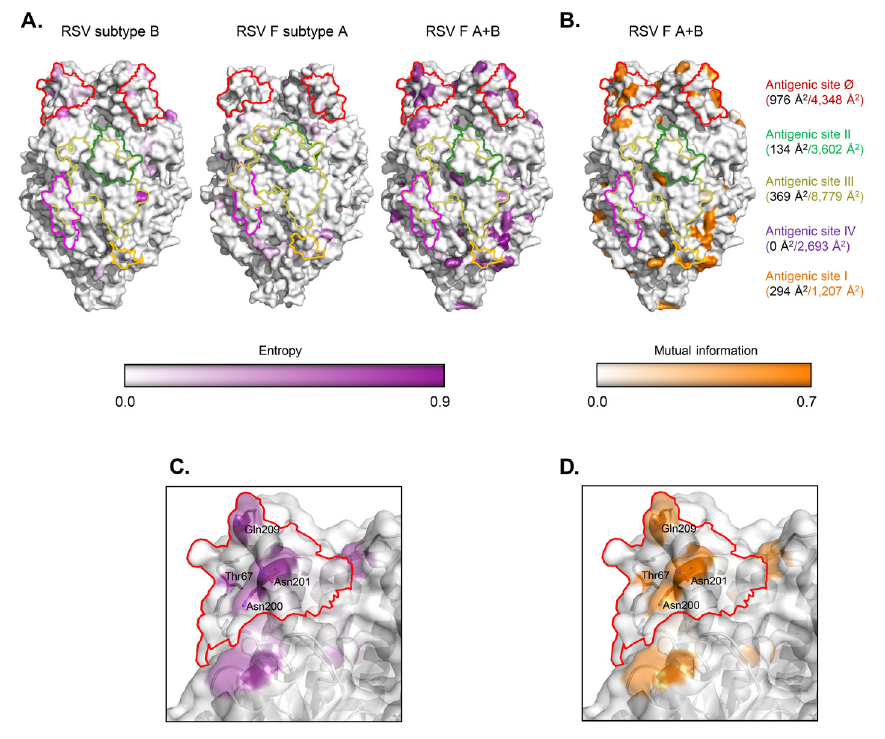
Figure 6. Surface antigenic differences between subtypes A and B . Surface antigenicity does not differ significantly within a subtype, but significant differences are observed between subtypes, with antigen- ic site Ø having approximately 23% surface variation. (A) Sequence entropy mapped on protein surface with a purple color scale as shown. (Left) Residue differences found within subtype B are mapped on the B18537 F structure; (Center) differences within subtype A are mapped on the A2 F structure; (Right) dif- ferences between subtypes A and B are mapped on the B18537 F structure. The antigenic sites are outlined with borders colored as in Figure 1. (B) Mutual information comparison of subtype B and subtype A se- quences mapped on the B18537 F structure. Total antigenic site surface areas (Å 2 ) as shown in Figure 1 are indicated to the right and colored the same as the antigenic site outline. Differences between subtypes are indicated in black fonts for each antigenic site. (C) Zoom-in view of subtype differences at antigenic site Ø as defined by sequence entropy. (D) Antigenic site Ø differences between subtypes A and B as defined by a mutual information metric. In (C) and (D), transparent trimer surface is shown overlaid on the cartoon representation with side chains shown in sticks for residues with significant